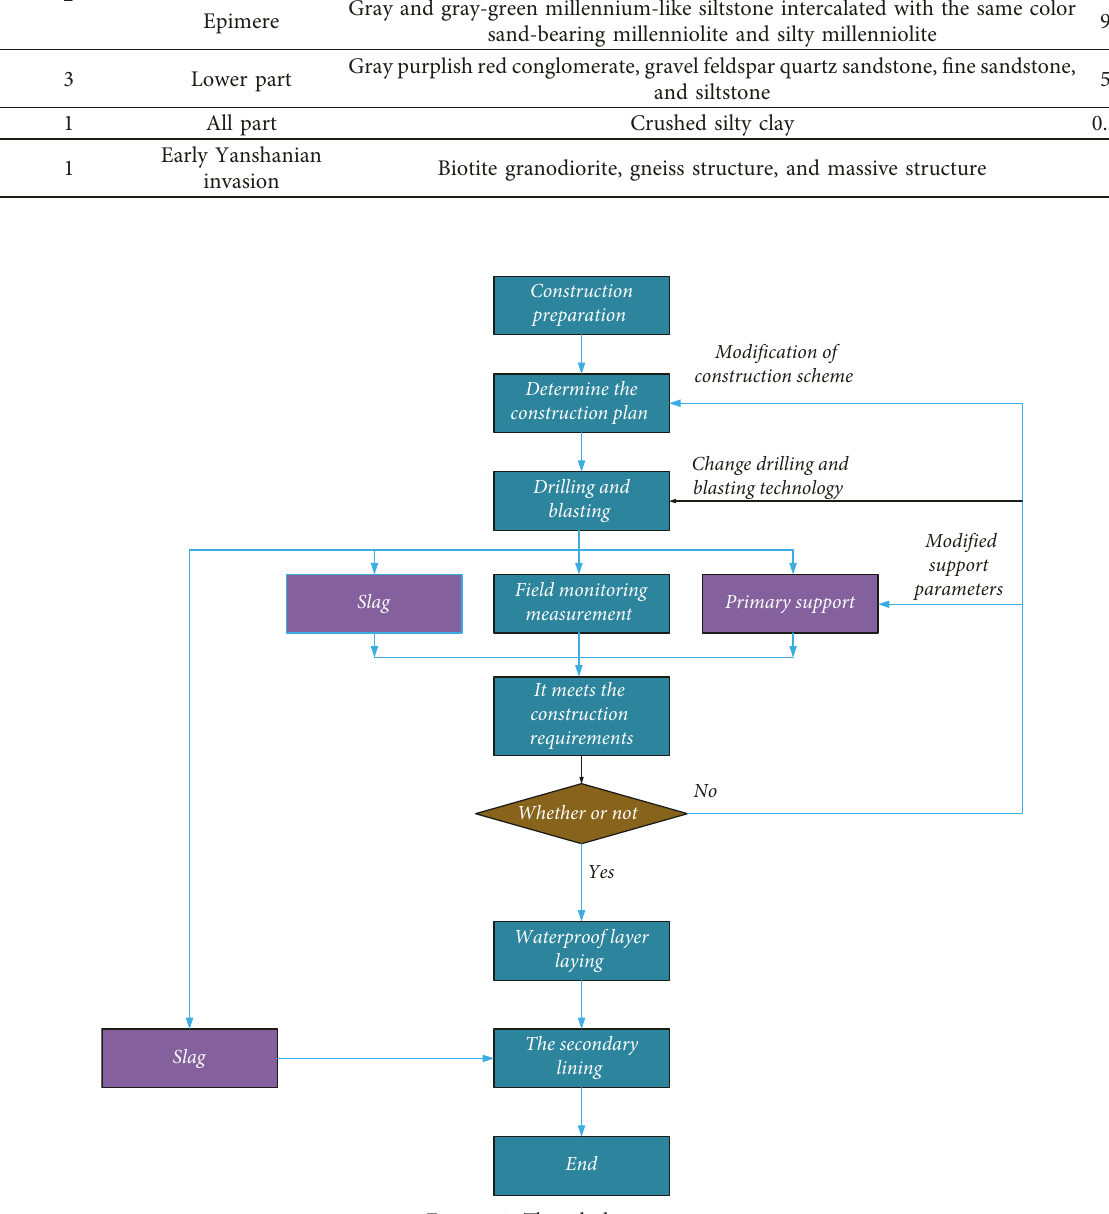
Figure 1: The whole process.